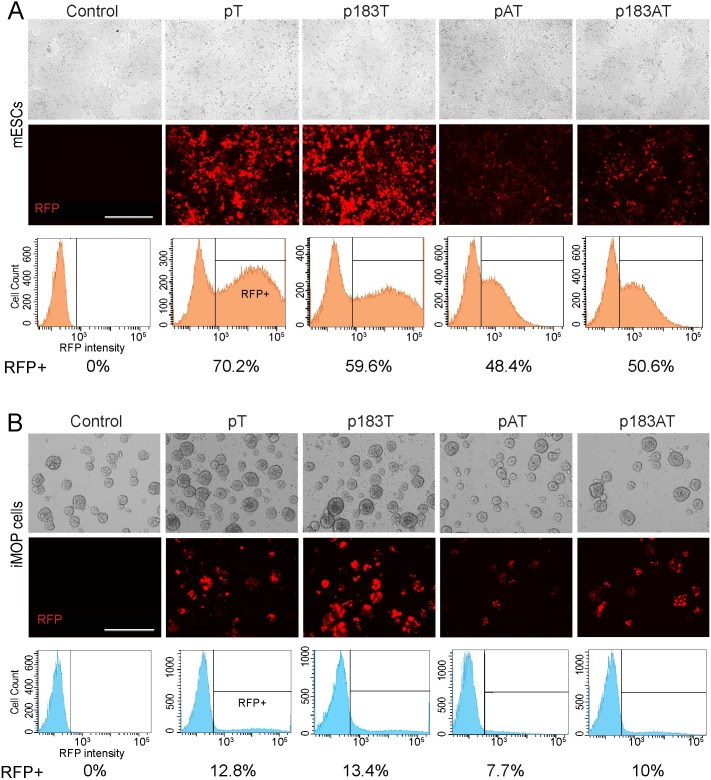
Fluorescence visualization and flow cytometric analysis of mESC and iMOP transfected cells.(A) mESCs at 48 h post-transfection with each of four plasmid vectors. (B) iMOP cells at 48 h post-transfection with each of four plasmid vectors. Bright field and fluorescence images are shown for corresponding fields (bar = 400 μm). Graphs depict representative results from flow cytometric analysis, where the threshold for RFP-positive cells was defined based on analysis of background levels of fluorescence detection in untransfected control cells. The average percentage of RFP-positive cells is indicated (n = 3).